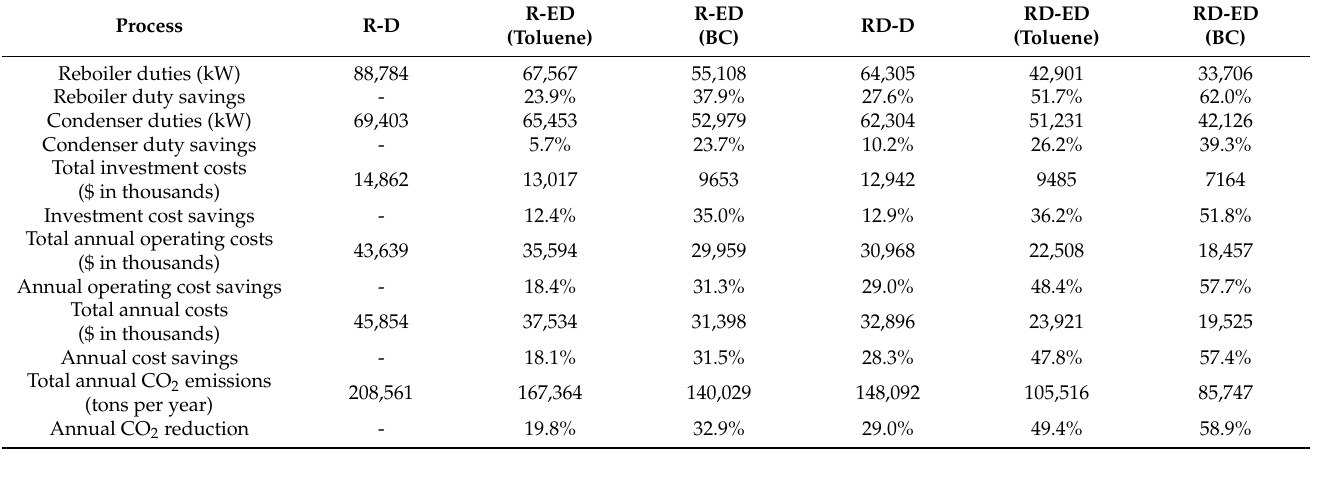
Table 4 lists the key results of all process alternatives, including the energy require- ments of the reboilers and condensers, TIC, TOC, TAC, and TCE. Remarkably, the hybrid RD-ED process with the BC solvent saved up to 51.8% and 57.4% TIC and TAC, respectively, compared to the R-D process. Figure 9 illustrates the costs and carbon emissions of all the processes. In terms of environmental impact, the hybrid RD-ED process with the BC solvent was the most favorable as it reduced TCE by 58.9% compared to the R-D process. Table 4. Comparison of different structural alternatives for furfural production process.